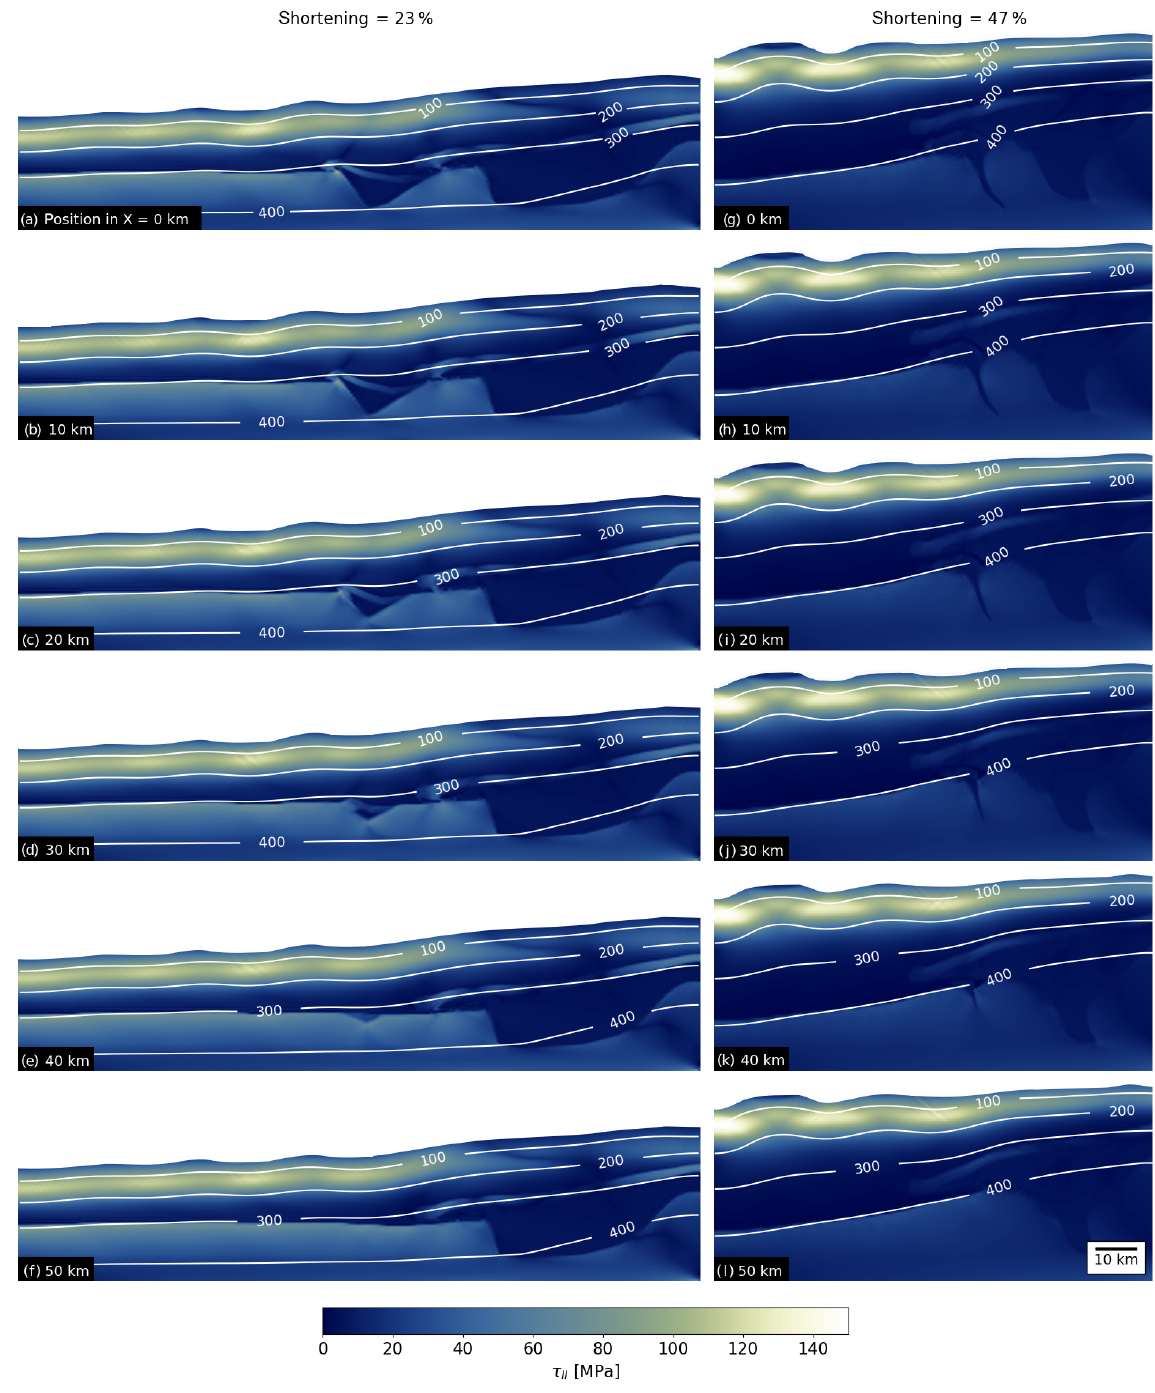
Figure 6. Graph showing lateral cross sections for two different states of bulk shortening for the second invariant of the deviatoric stress τ II of model A.G-1. Cross sections are taken in 10km steps from X = 0 to X = 50km. Additionally, we display the isothermal lines in degrees Celsius ( ◦ C). Columns correspond to the bulk shortening state and rows to cross-section X position (colour map from Crameri